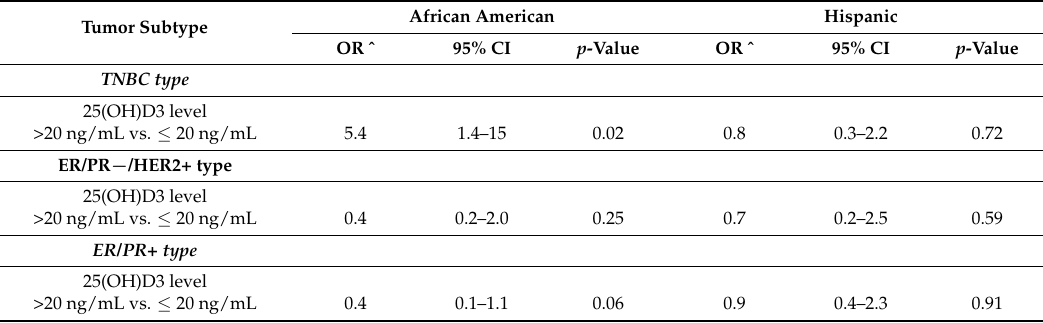
Table 6. Association of 25(OH)D3 level and subtypes of breast